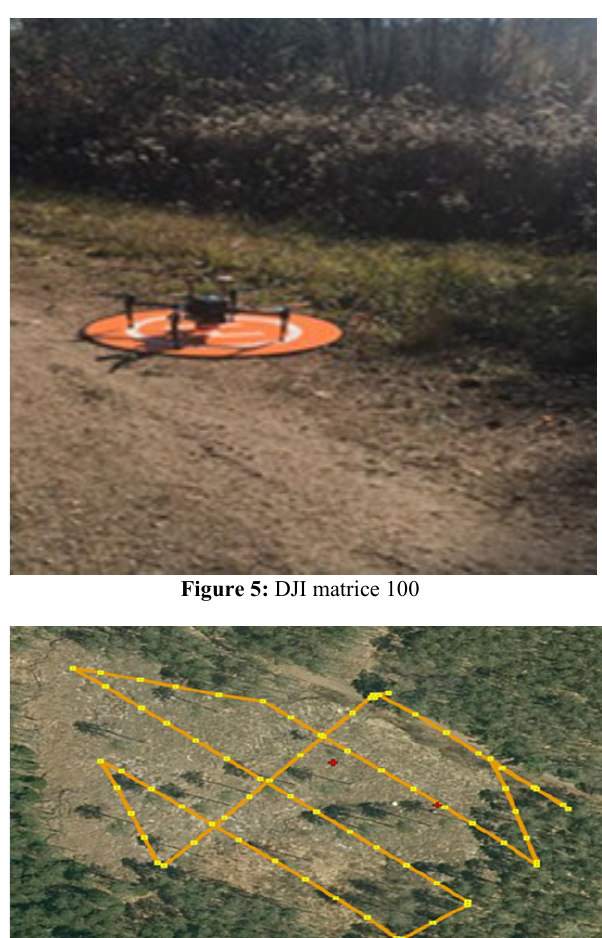
Figure 6: UAV flight path.